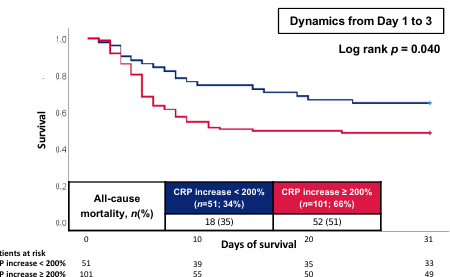
Figure 4. Kaplan–Meier curves of CRP dynamics from day 1 to 3 for all-cause mortality at 30 days.